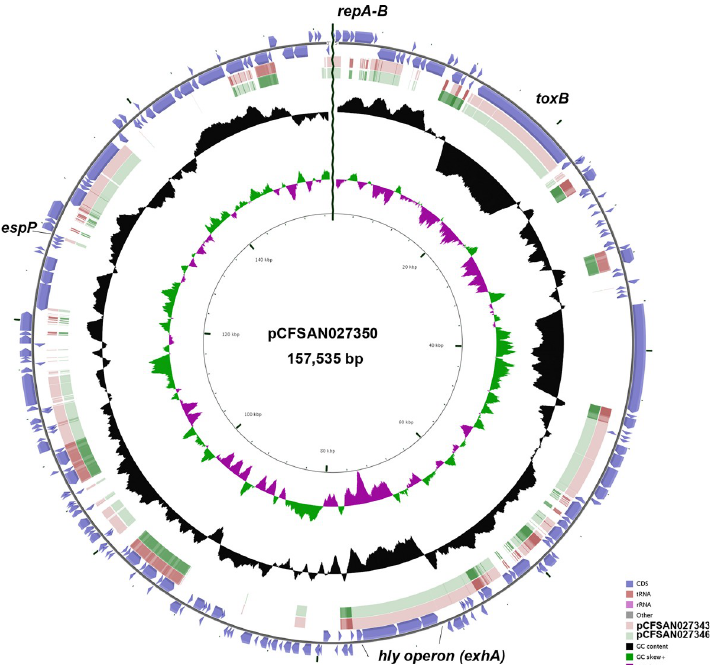
Fig 4. Circular map of virulence plasmid pCFSAN027350 compared to the other two virulence plasmids (pCFSAN027343 and pCFSAN027346), generated using CGView [63]. Blue block arrows in the outer circle denote coding regions in the plasmid, indicating the ORF transcription direction. G+C content is shown in the middle circle and the deviation from average G+C content (47.71%) is displayed in the innermost circle. BLAST comparisons with the other two EHEC plasmids are shown in light red (pCFSAN027343) and green